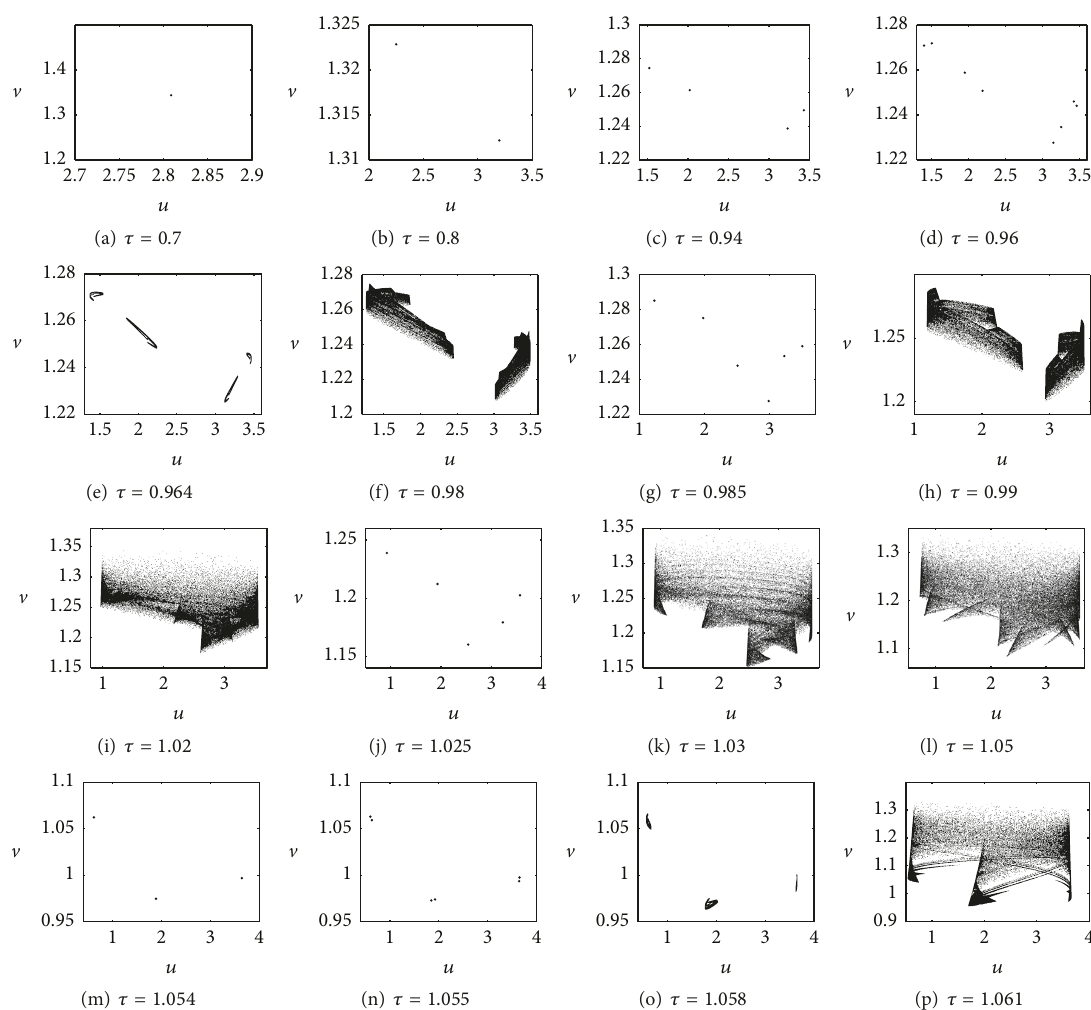
Figure 2: Phase portraits for various values of 𝜏 corresponding to Figure